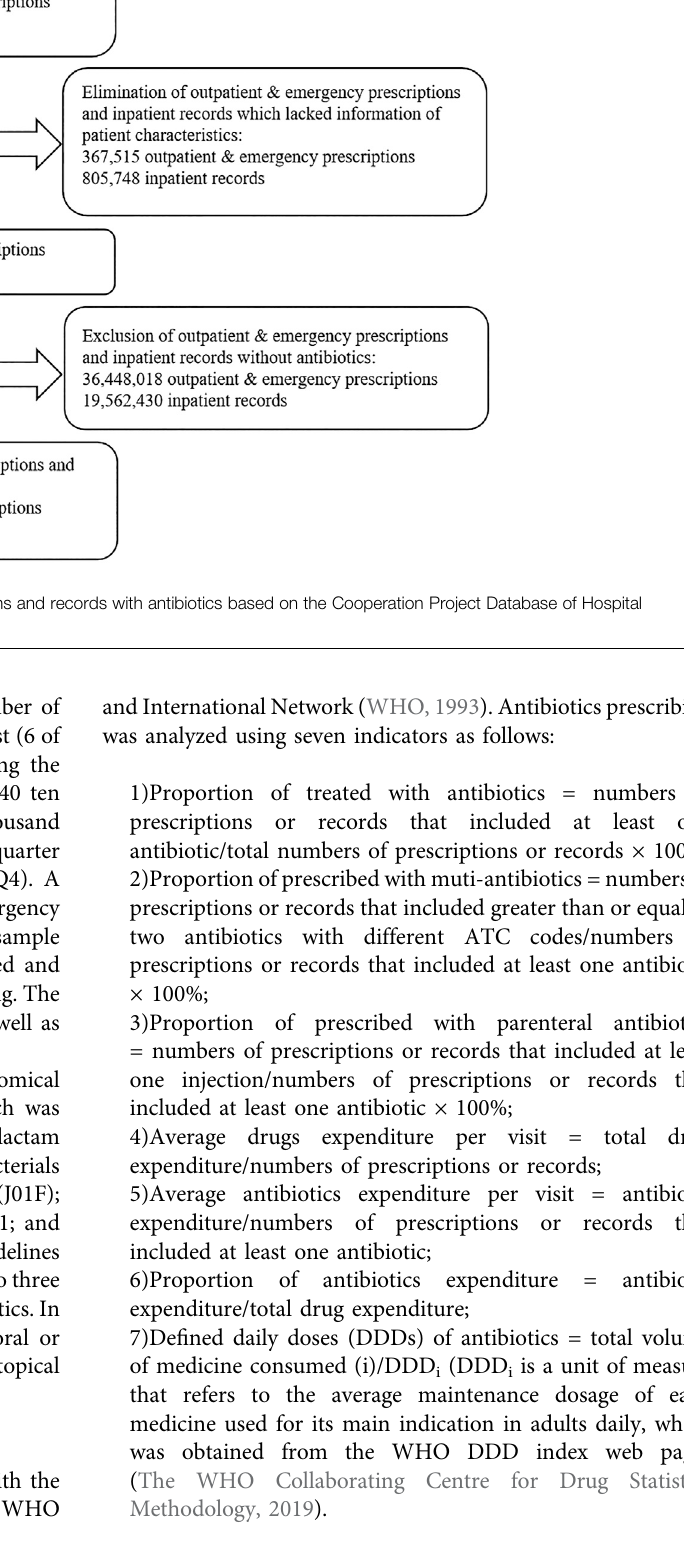
Frontiers in Pharmacology |